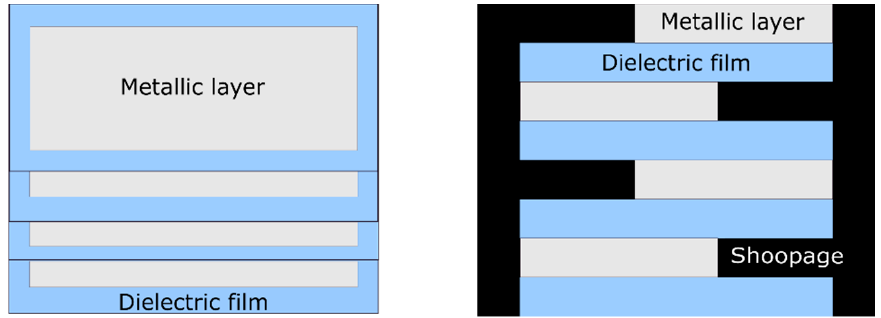
Figure 3. Stacked metallized capacitors.